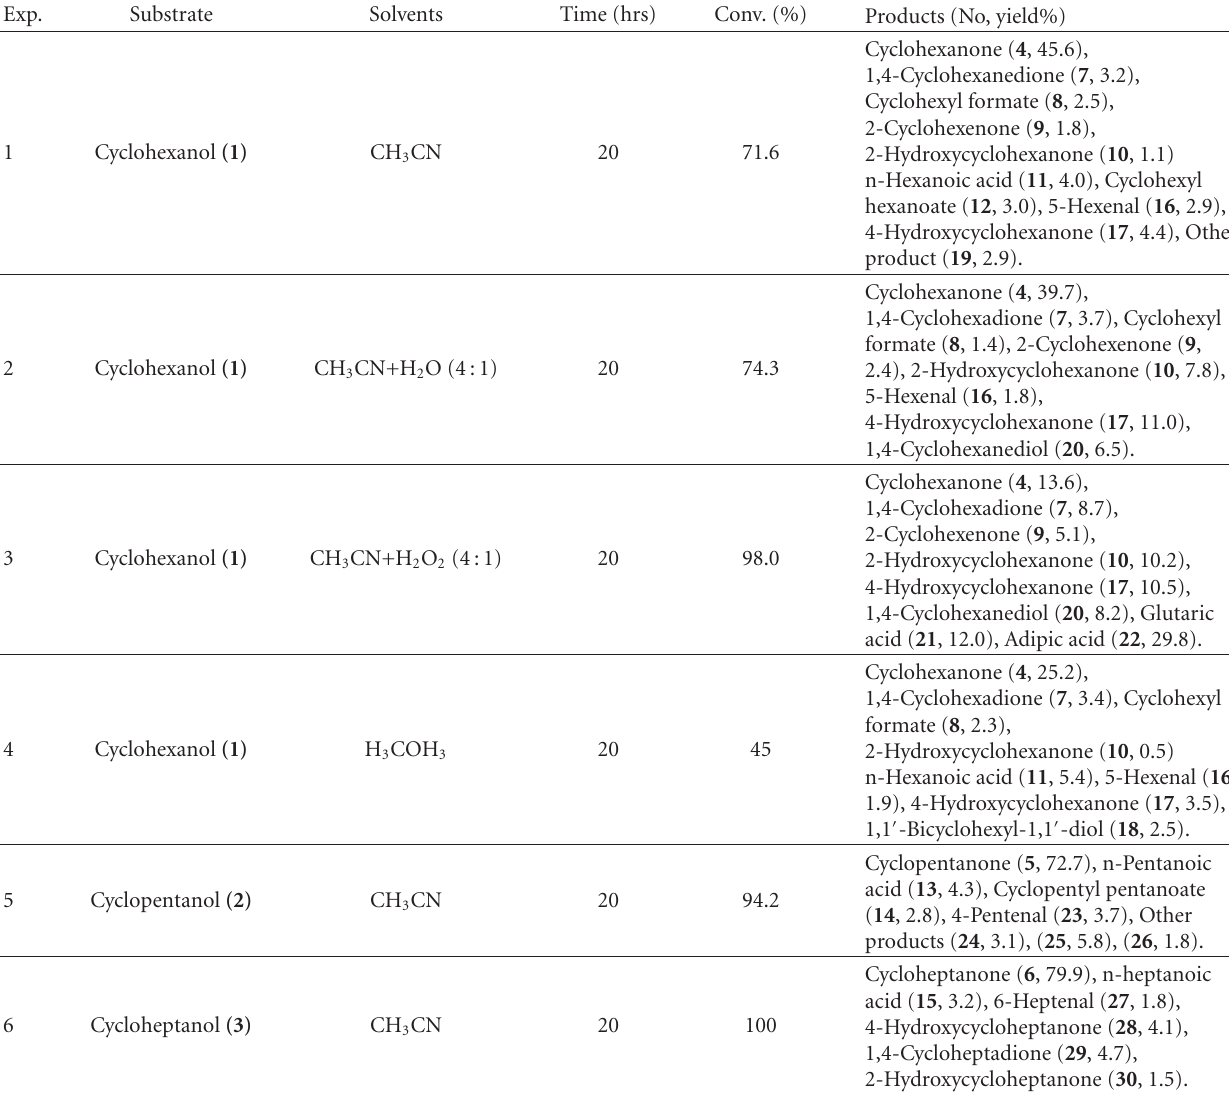
Table 1: Photocatalytic oxidation of the investigated cyclalkanols 1 – 3